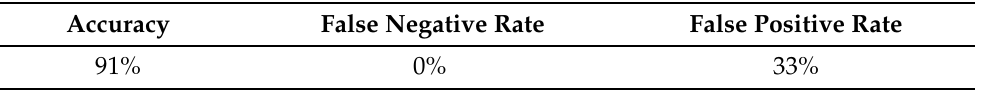
Figure 10. A snapshot of the captured I/O trace records. Table 1. The detection results using real-world malware samples.